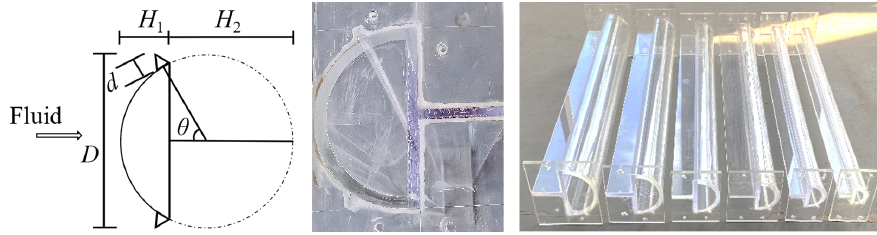
Figure 3. Physical model of the Cir-T-Att oscillator. All oscillators were 0.9 m long and made of polymethyl methacrylate. Considering the boundary e ff ect zone, two end plates are set at both ends of the oscillator, and the thickness of the end plate is designed as δ = 0.01 m. Model diameters are 0.06, 0.08, 0.10, 0.12, 0.14, and 0.16 m. As referred to in the fl ow regime classi fi cation by Zdravkovich et al. [25], the test range is in the TrSL2, TrSL3, and TrBL0 regimes. Table 2. Test condition.